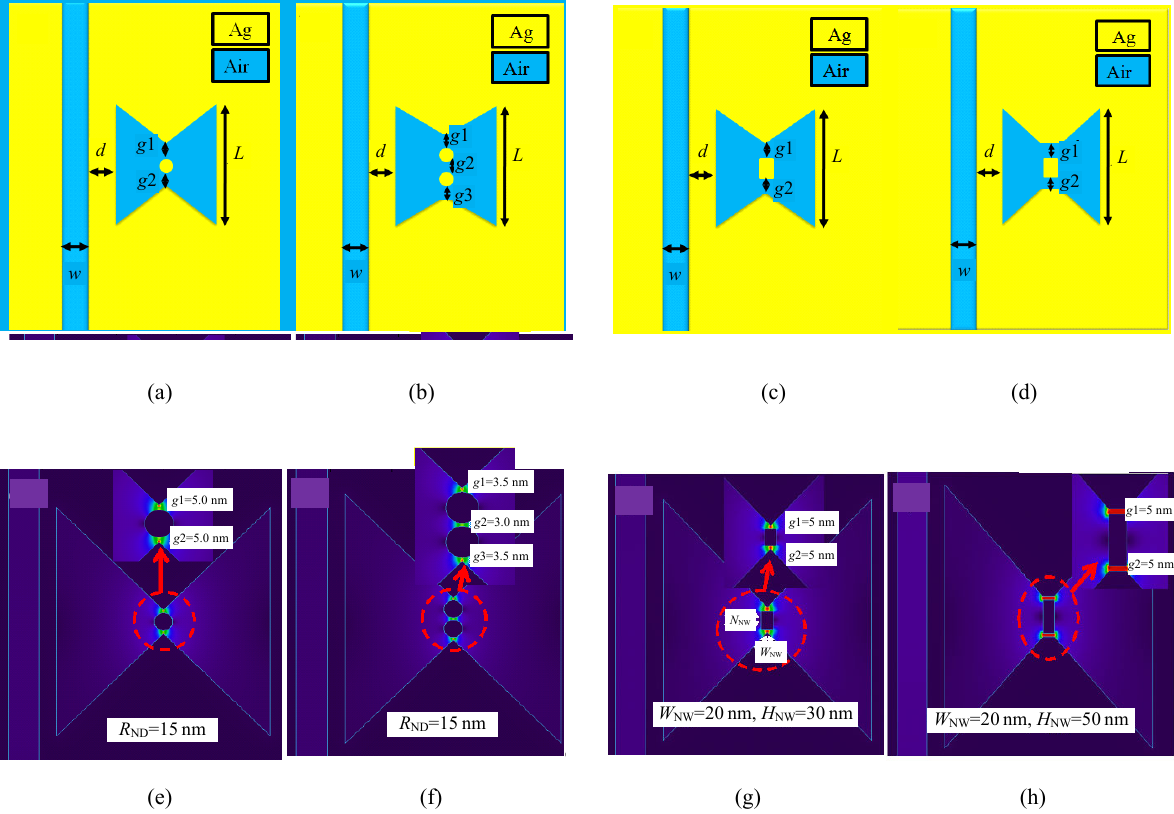
Fig. 3 Schematic of (a) ND incorporated in the standard BT scheme, (b) two NDs vertically embedded in the standard BT scheme, (c) NW incorporated in the standard BT scheme, (d) NW incorporated flat boundaries BT scheme, and (e)–(h) E-field distributions in design configurations as mentioned in (a), (b), (c) and (d),